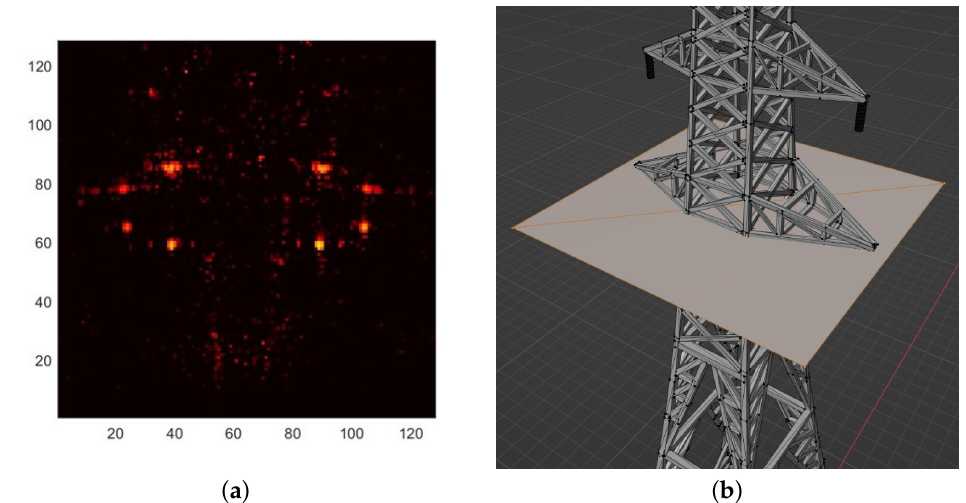
Figure 10. Height slice of electricity pylon at 20.7m. ( a ) Weighted MIRF; ( b ) Detail from CAD